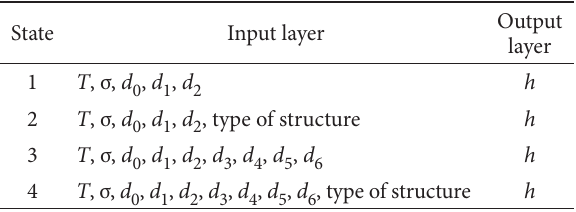
Table 2. Configurations of input and output layers tested with ANN